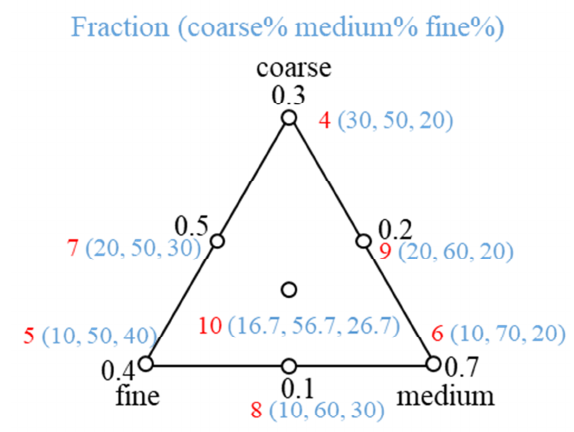
Figure 2. Di ff erent particle size fraction choices based on simplex-centroid design. Figure 2. Different particle size fraction choices based on simplex-centroid design.